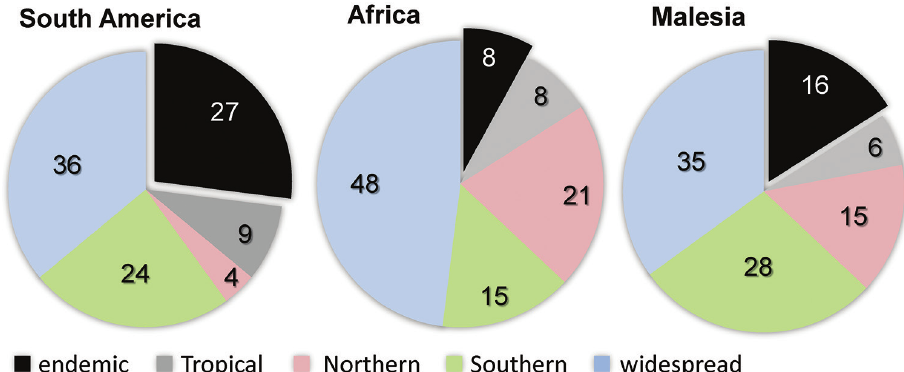
Figure 2. Relative contribution of in situ speciation and immigration to species richness in selected tropical alpine regions (pie charts on the left). Blue: in situ speciation, green: colonisation, light blue: un- certainty regarding in situ speciation, light green: uncertainty about colonisation. In the right pie charts, colonisation is further decoupled into species derived from other regions with alpine-like climate (black) and species that originated by colonisation from a different biome (red). Uncertainty is indicated by